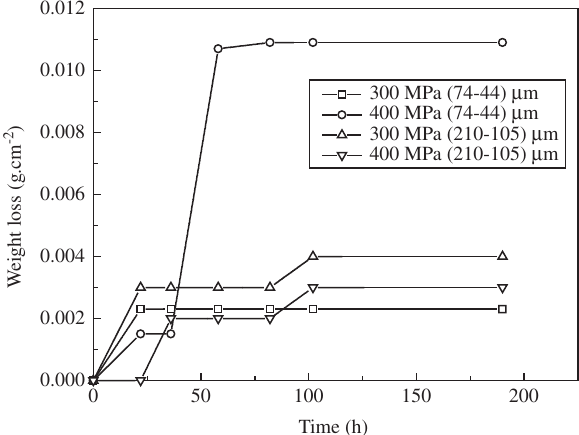
Figure 2. Weight losses of filters after increasing times of immersion in naturally aerated 0.5M H